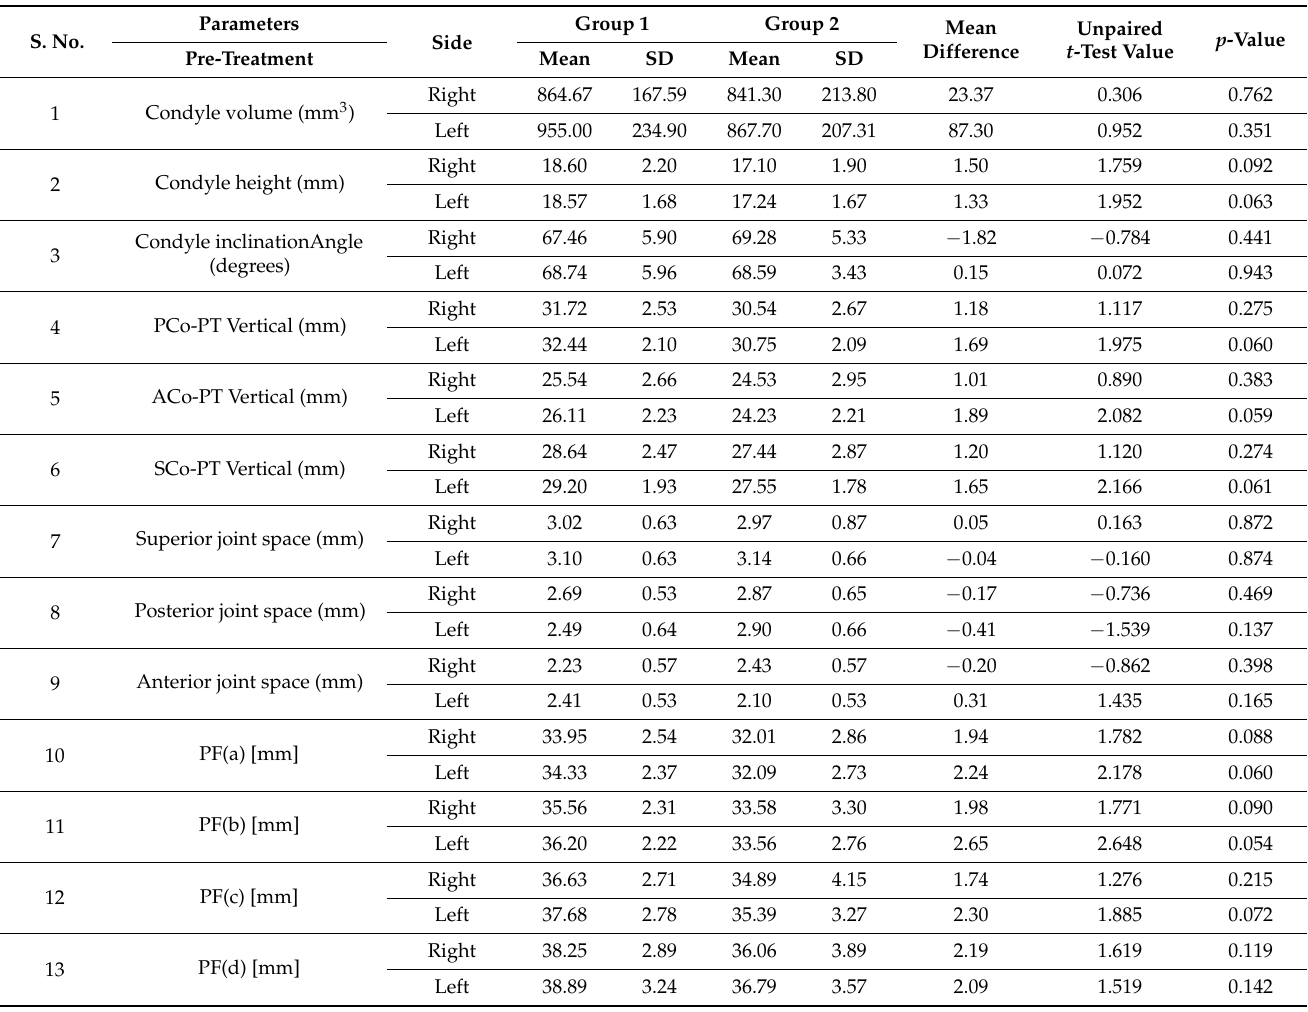
Table 2. Intergroup pretreatment comparison for condyle-glenoid fossa variables.